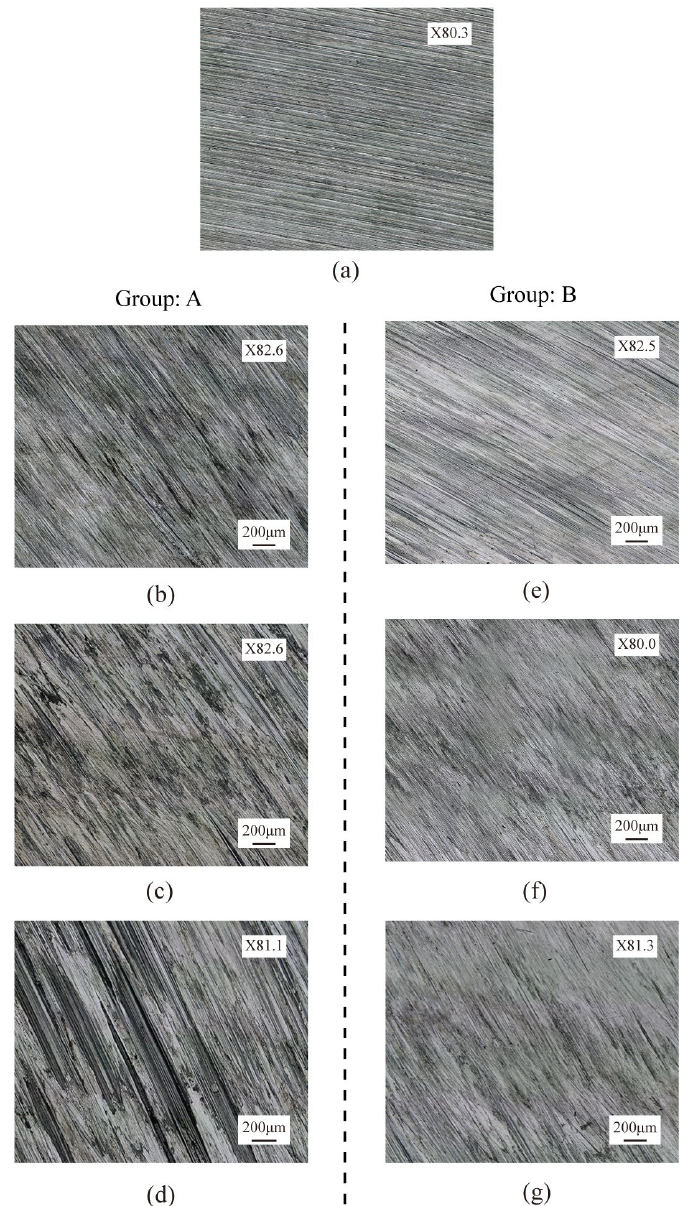
Figure 7. Optical morphologies of rail samples: ( a ) before grinding; ( b ) 30 s first grinding (A 1 ); ( c ) 30 s second grinding (A 2 ); ( d ) 30 s third grinding (A 3 ); ( e ) 10 s first grinding (B 1 ); ( f ) 10 s second grinding (B 2 ); ( g ) 10 s third grinding (B 3 ).